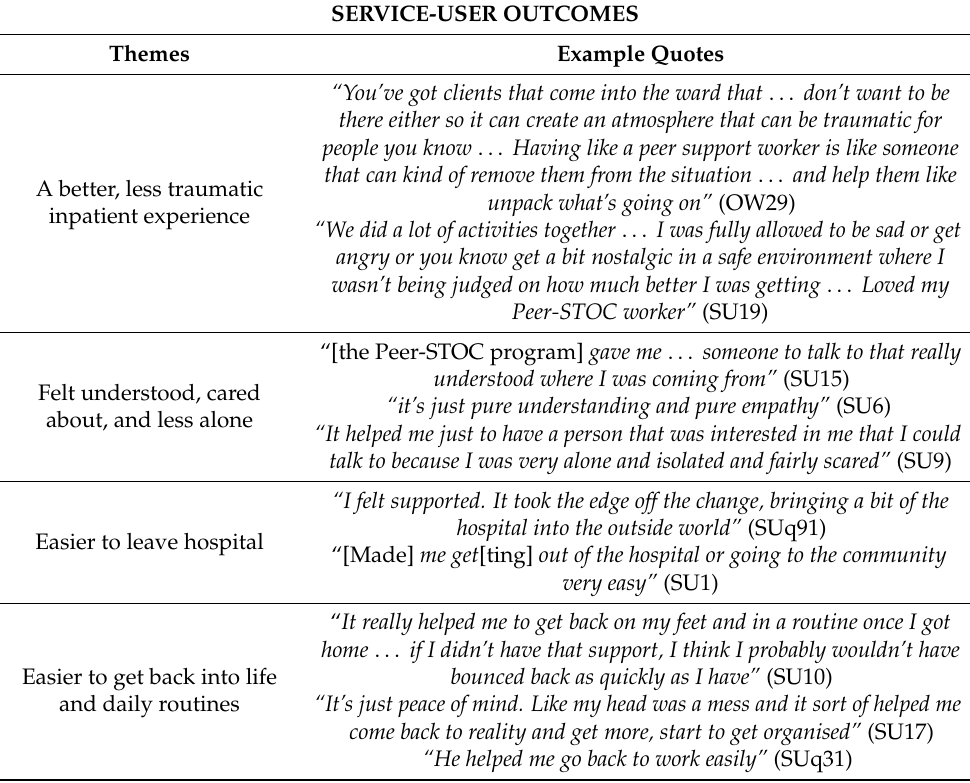
Table 2. Synthesis of service-user outcomes from all stakeholder